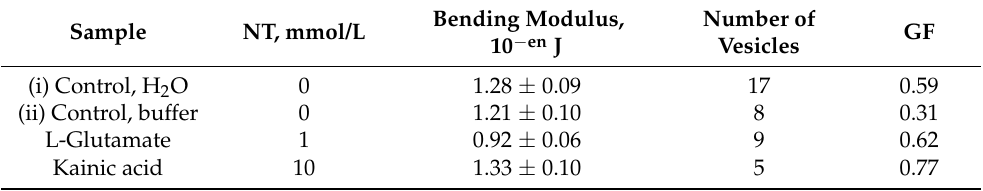
Table 1. Bending elasticity of POPC membranes and the effect of the neurotransmitters (NT) L-Glu and KA; data acquired from TSFA of GUVs at (37 ± 0.1) ◦ C control sets of measurements performed in: (i) bidistilled water and (ii) 50 mM Tris-HCl buffer, pH 7.2; GF—goodness of fit ( χ 2